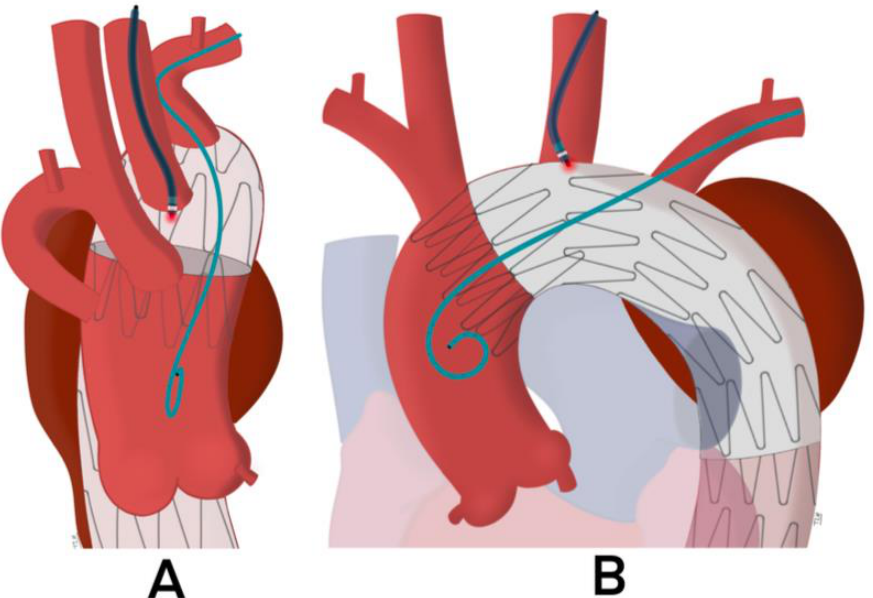
Figure 3. After the apposition of the guide catheter in contact with the aortic graft, the appropriate positioning should be evaluated in the anteroposterior and lateral view before the laser probe activation. The distal end of the guide catheter must be positioned at a 90 ◦ angle with the surface of the fabric of the stent graft. (( A ): lateral and ( B ): anteroposterior view):